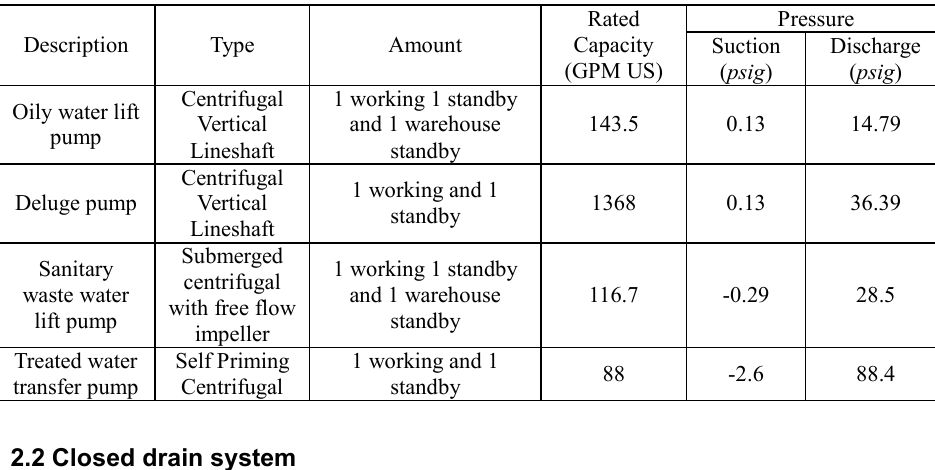
Table 1. Technical characteristics of pumps used in drainage